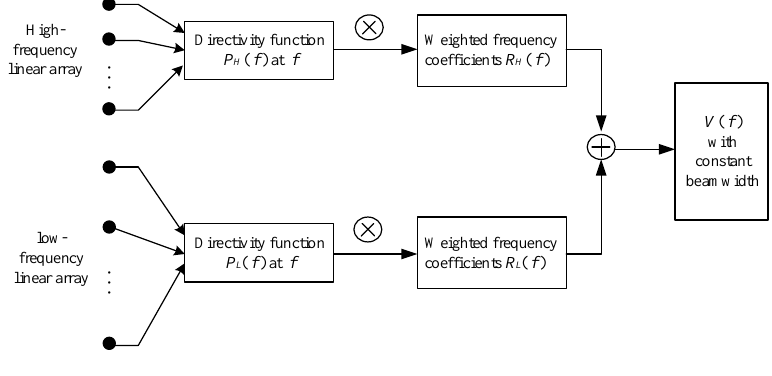
Figure 5. The example of explaining the harmonic nesting